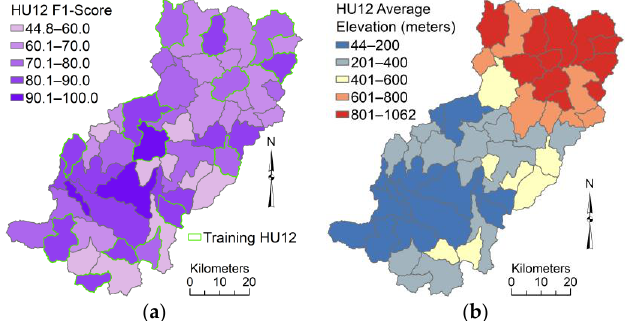
Figure 12. Spatial distribution of ( a ) F1-scores for HU12 watersheds for hydrography predictions from U-net model using 14 HU12 watersheds for training (green boundaries), and ( b ) of average elevation values for each HU12 watershed in the 50 HU12 study area.